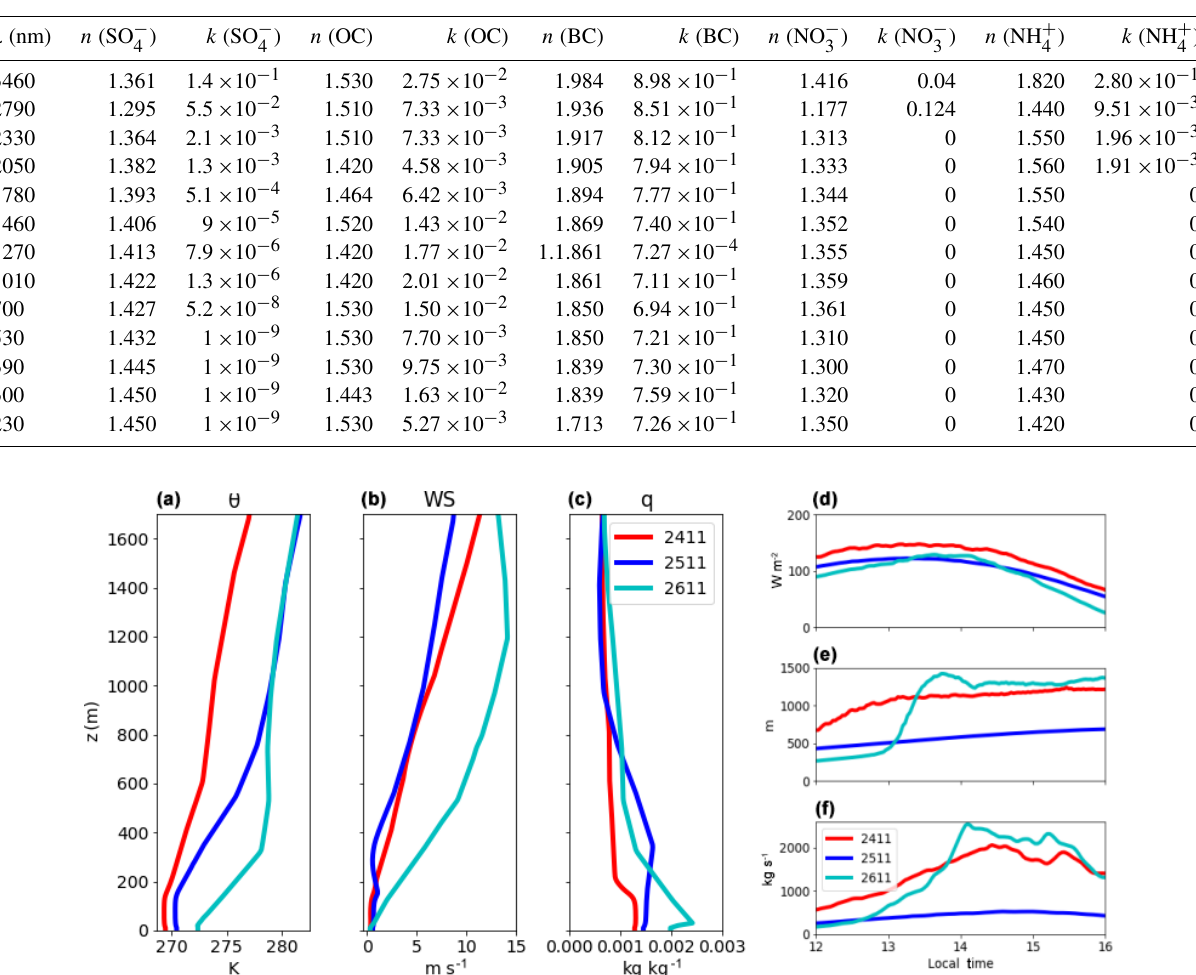
Table 1. Real ( n ) and imaginary ( k ) refractive indices across 13 shortwave wavelengths ( λ for all aerosol components considered for aerosol– radiation interactions in this simulation.